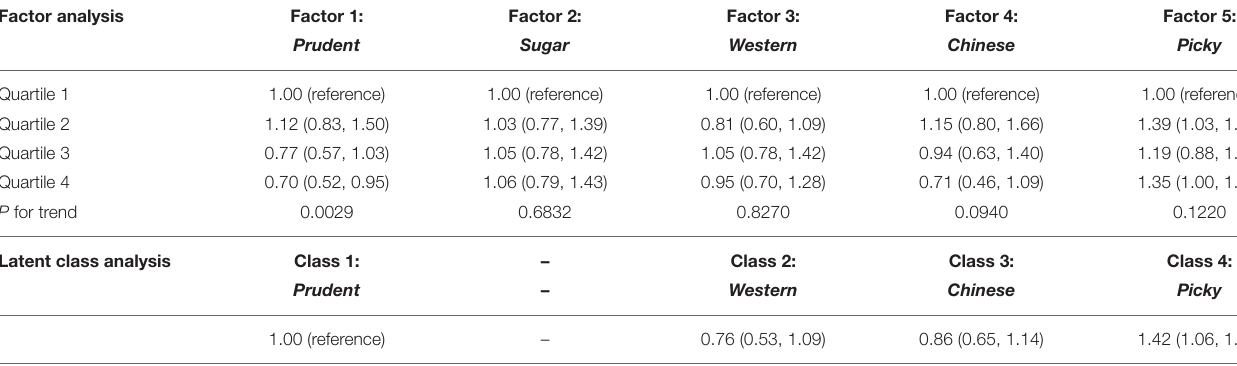
TABLE 6 | Associations between the dietary patterns derived by FA and LCA and health outcome (breast cancer) a , adjusted OR and 95% CI b . Factor